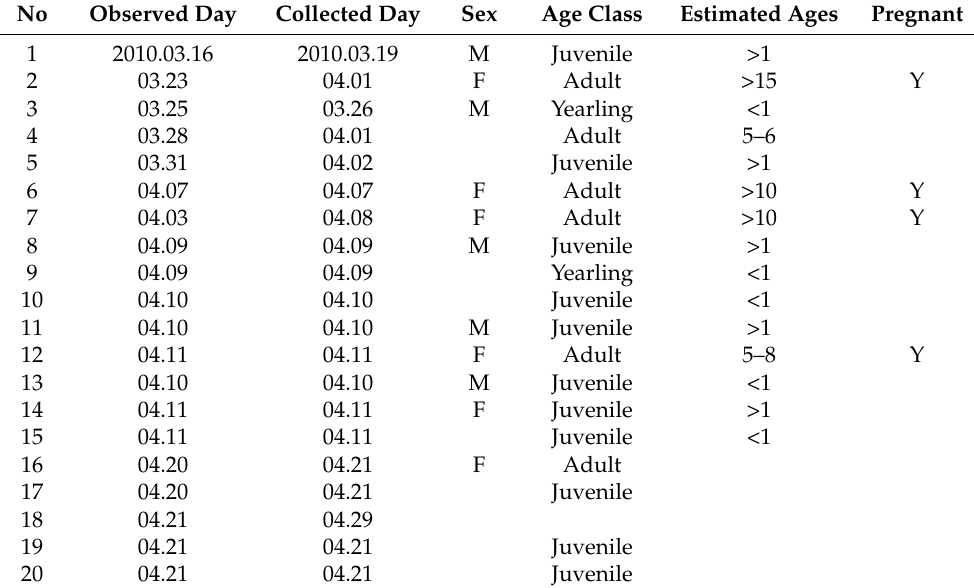
Table 2. Carcass information (observed and collected day, sex, age class (yearling: age < 1, juvenile 1 < age < 3, adult > 3), estimated ages, and pregnancy; CGRB,